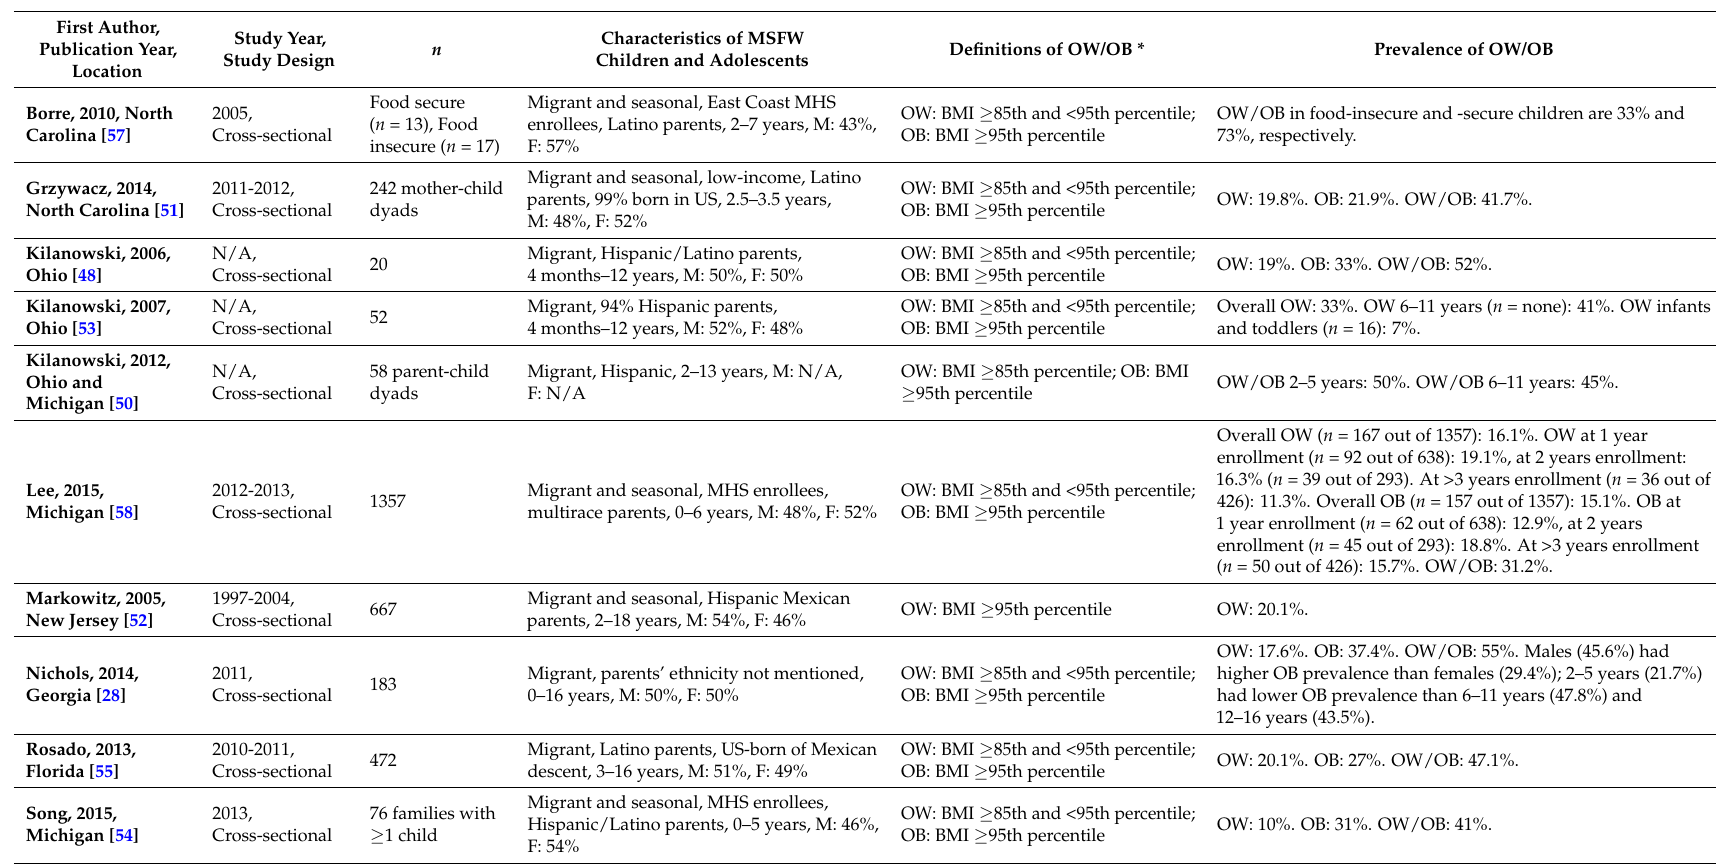
Table 1. Overweight and obesity